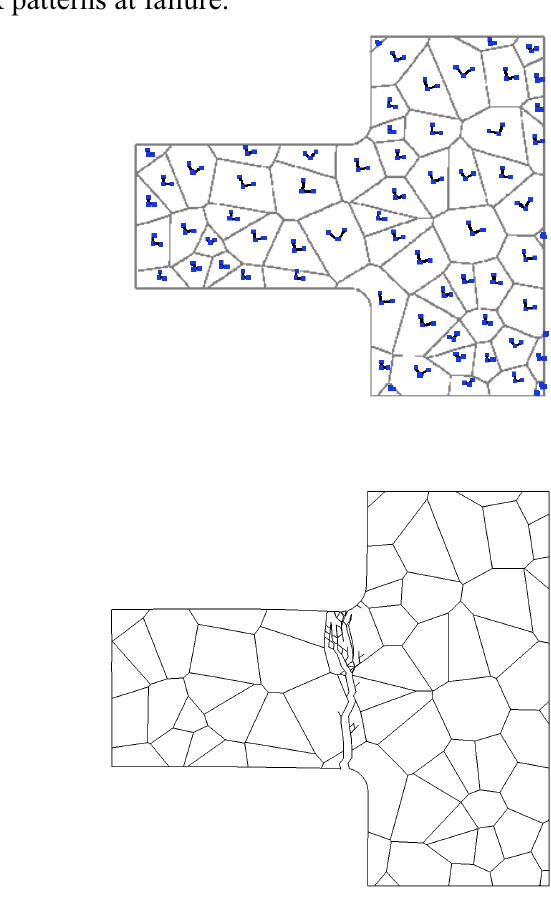
 M t GPa, 5.2  M t GPa): effect of G GB